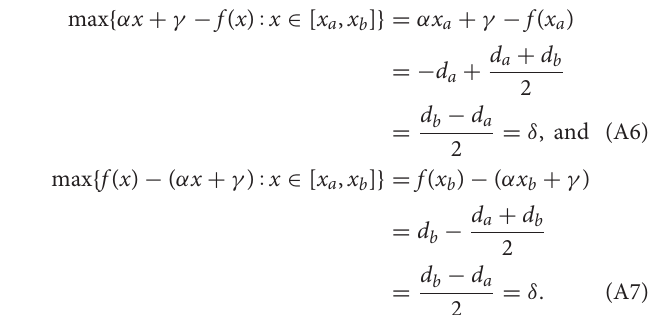
Algorithm 1 maintains correctness of ranges computed by affine Chebyshev and Min-Range approximations of a univariate function ˆ